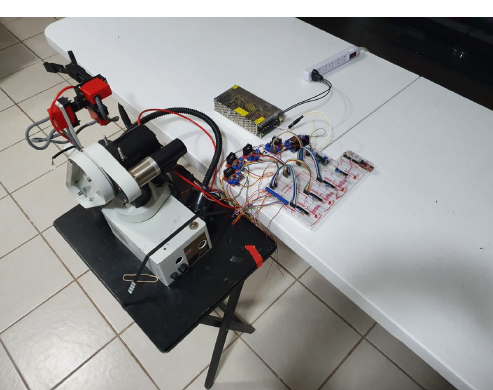
Figure 8. The 6DOF manipulator with SDEI.